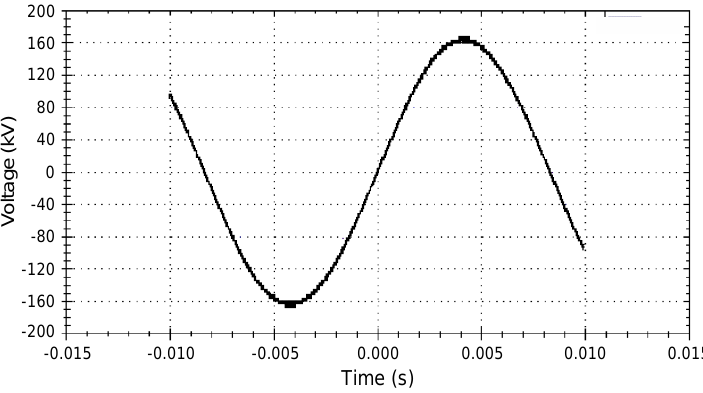
Figure 15. Application of RMS 119.5 kV to the bushing.